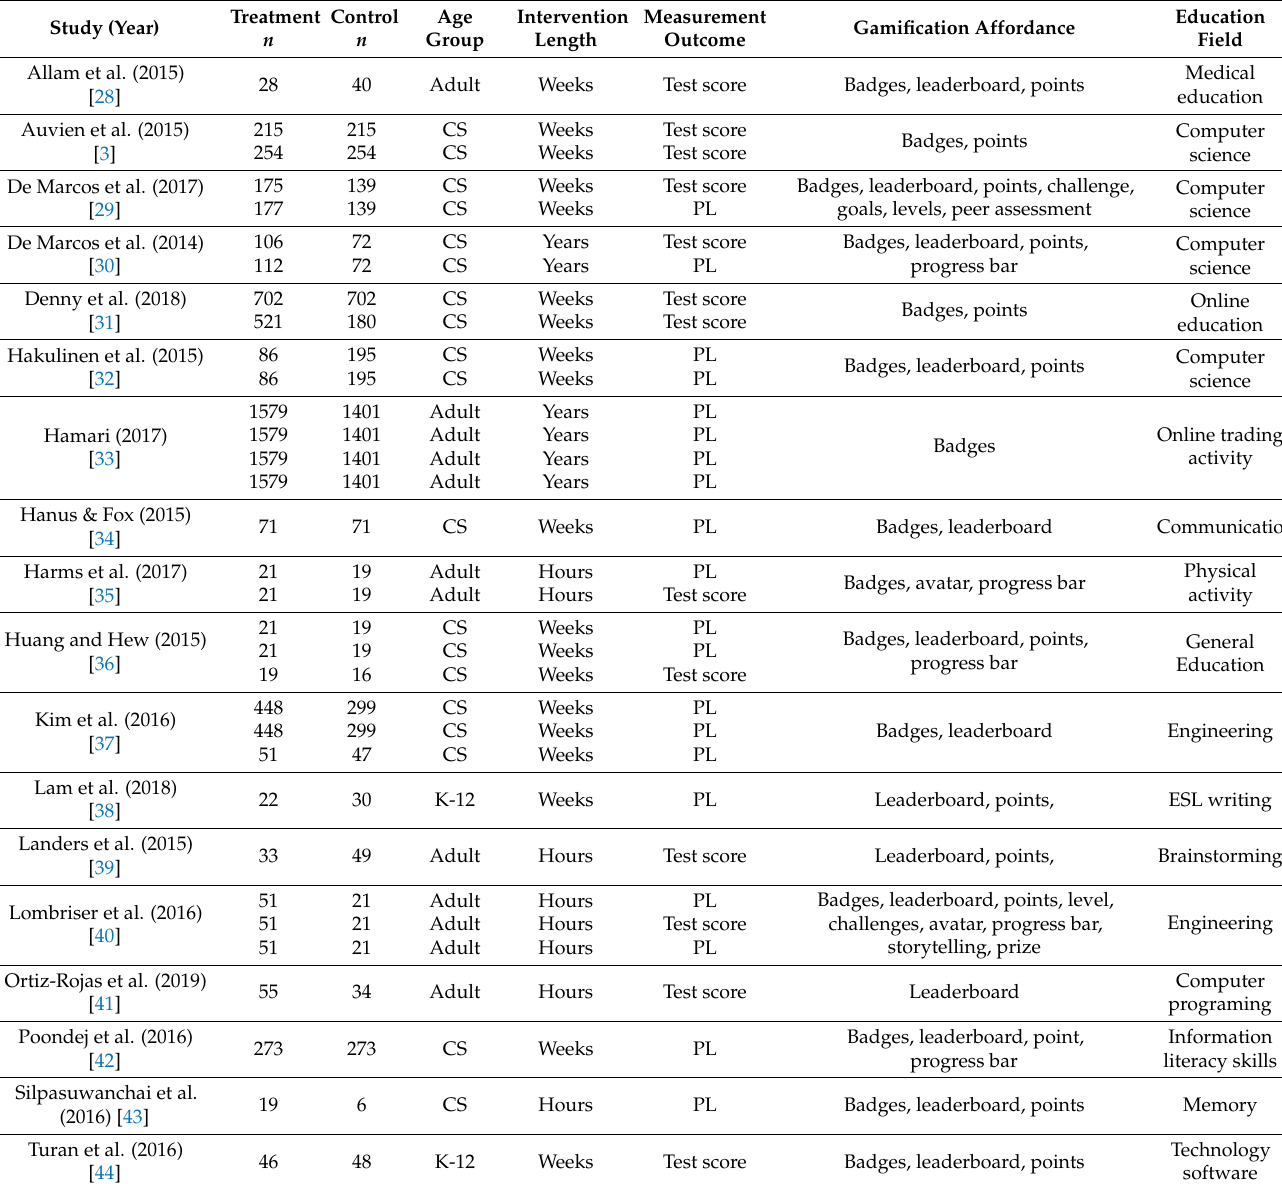
Table 1. Characteristics of gamification intervention studies included in the